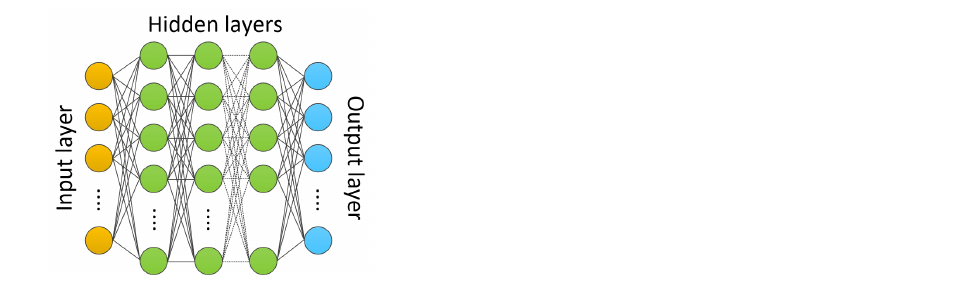
Figure 8. An example of Deep Neural Networks with input, output, and hidden